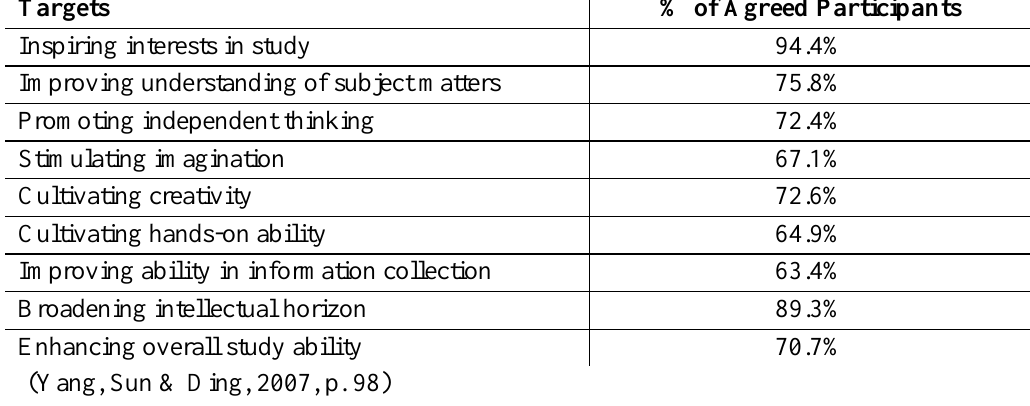
Fostering Student Development: Gansu Province Targets % of Agreed Participants Inspiring interests in study Improving understanding of subject